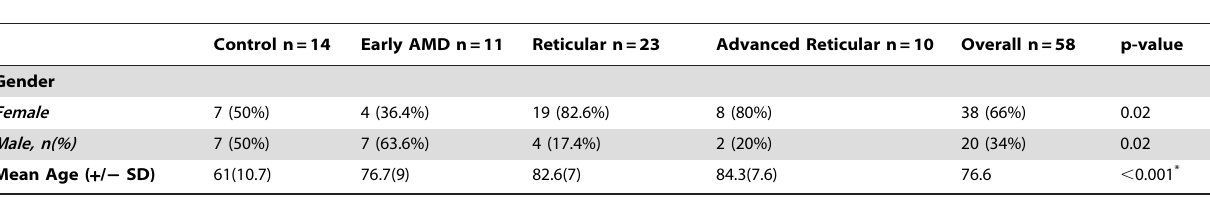
Table 1. Patient Demographics.